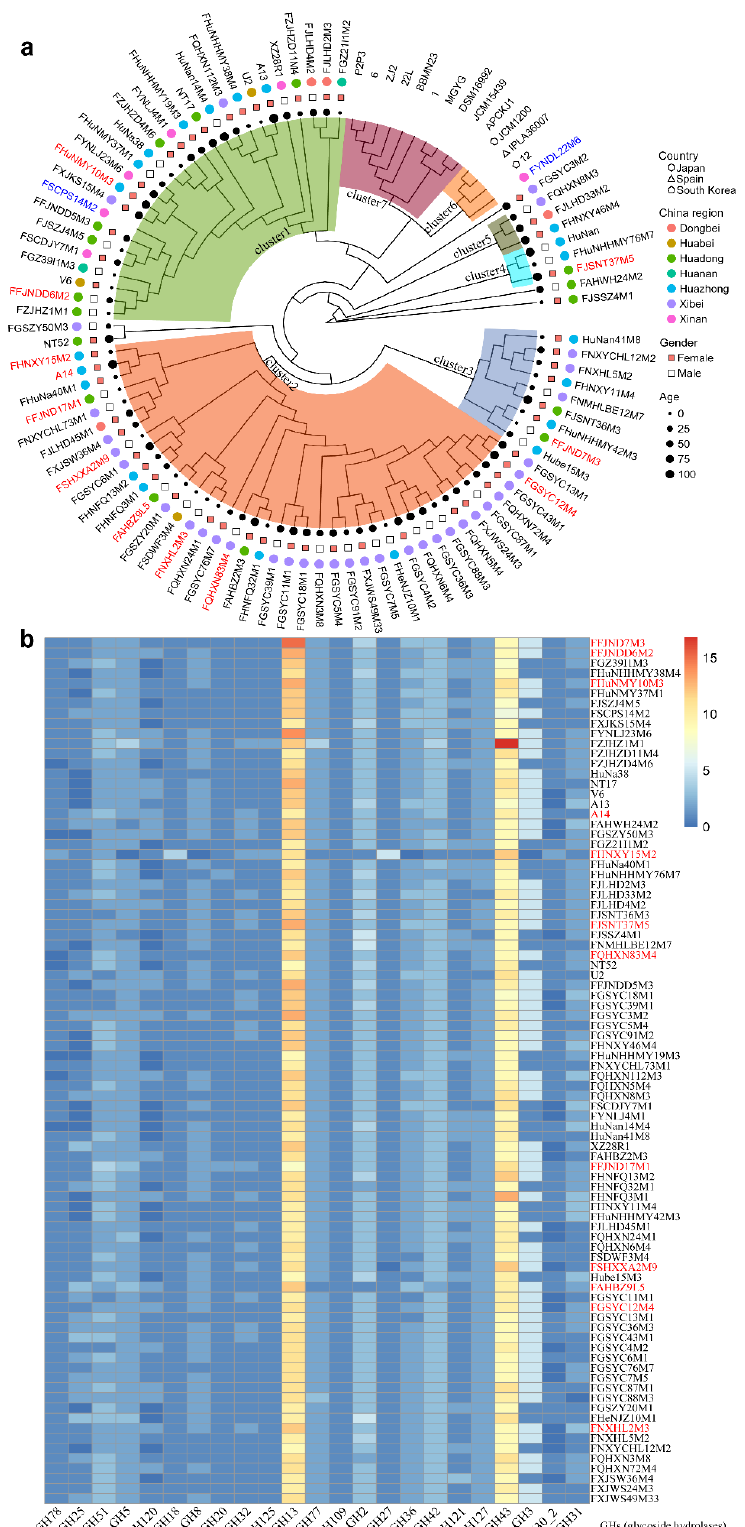
Figure 2. Phylogenetic tree based on single copy gene orthologous group and distribution of carbohydrate-active enzyme within 88 B. pseudocatenulatum strains ( a , b ). The color scales represent the number of GH (glycoside hydrolases) families that existed in each strain, with blue representing the absence of matches and red squares representing the highest number of GH